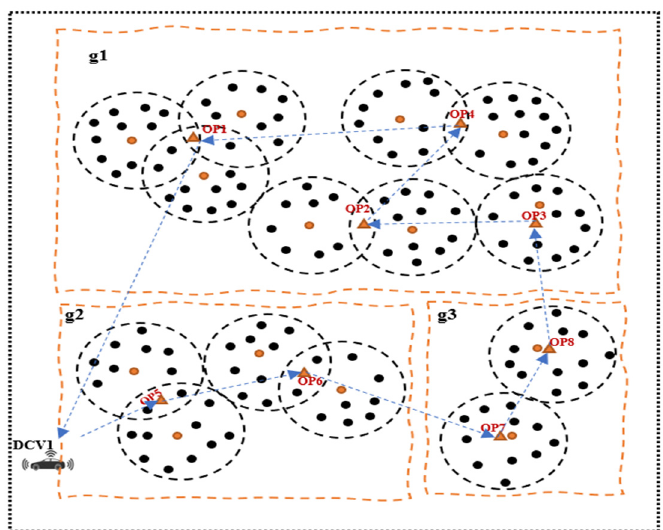
Figure 10. A working example of the proposed model using a single DCV.